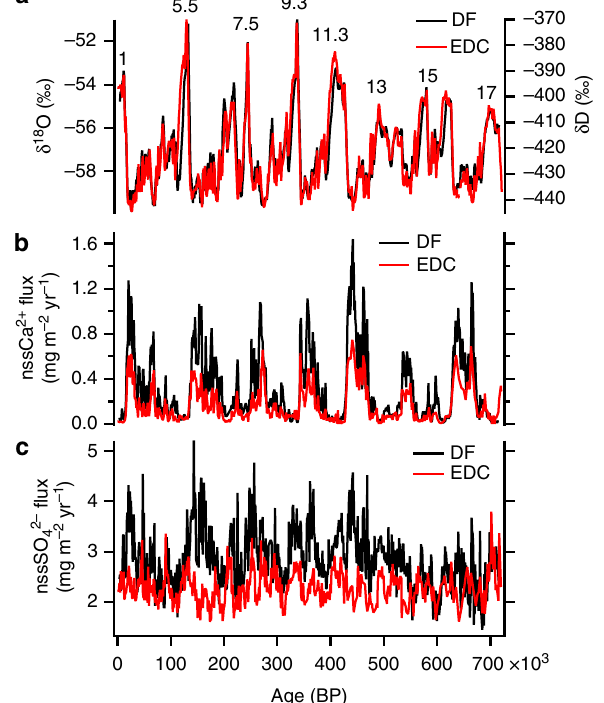
Fig. 1 Temperature proxies and ion fl uxes at Dome Fuji (DF) and Dome C (EDC). a The δ 18 O (DF) 14 and δ D (EDC) 7,8 records averaged over